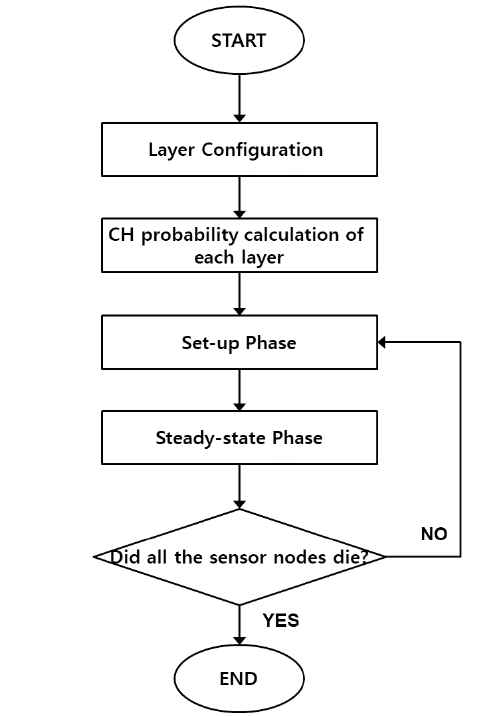
Figure 7. Steps of Direction-based LEACH